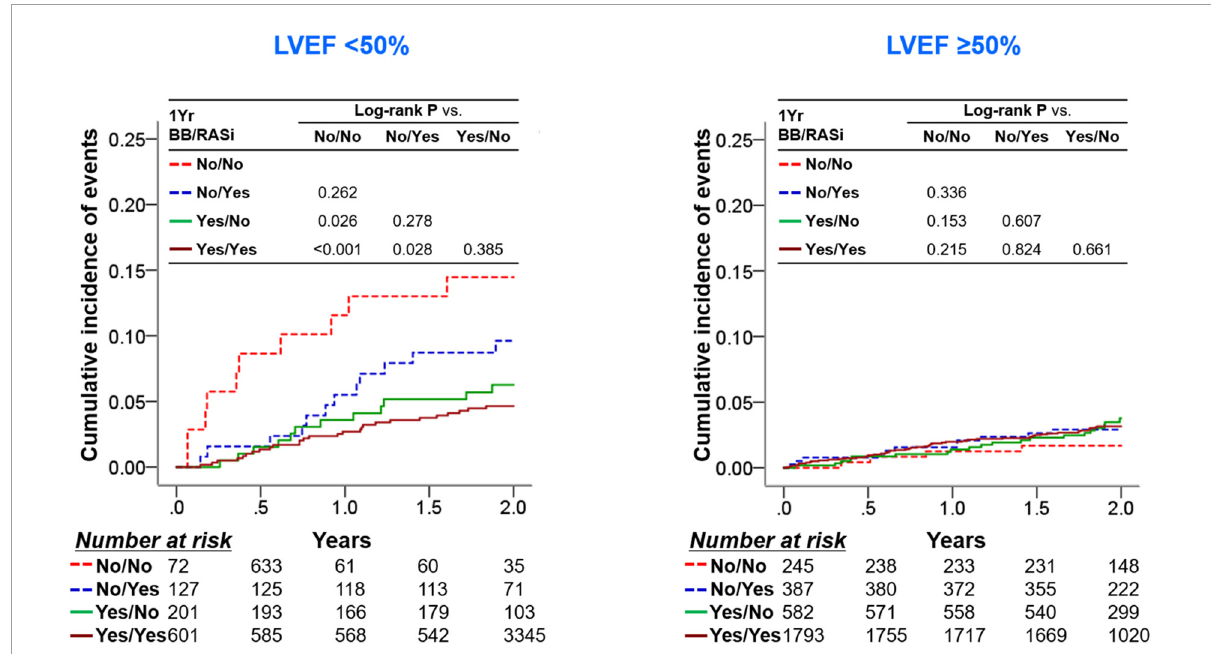
FIGURE4 Clinical outcomes according to use of RASi and BB at 1-year follow-up and 1-year LVEF. In each group of patients with a 1-year LVEF < 50% and with a 1-year LVEF ≥ 50%, patients were stratified into four subgroups according to the RASi medication and beta-blocker medication at the 1-year follow-up. Kaplan-Meier survival curves for 2-year all-cause mortality from the 1-year follow-up are shown. BB, beta-blocker; LVEF, left ventricular ejection fraction; RASi, renin-angiotensin-system